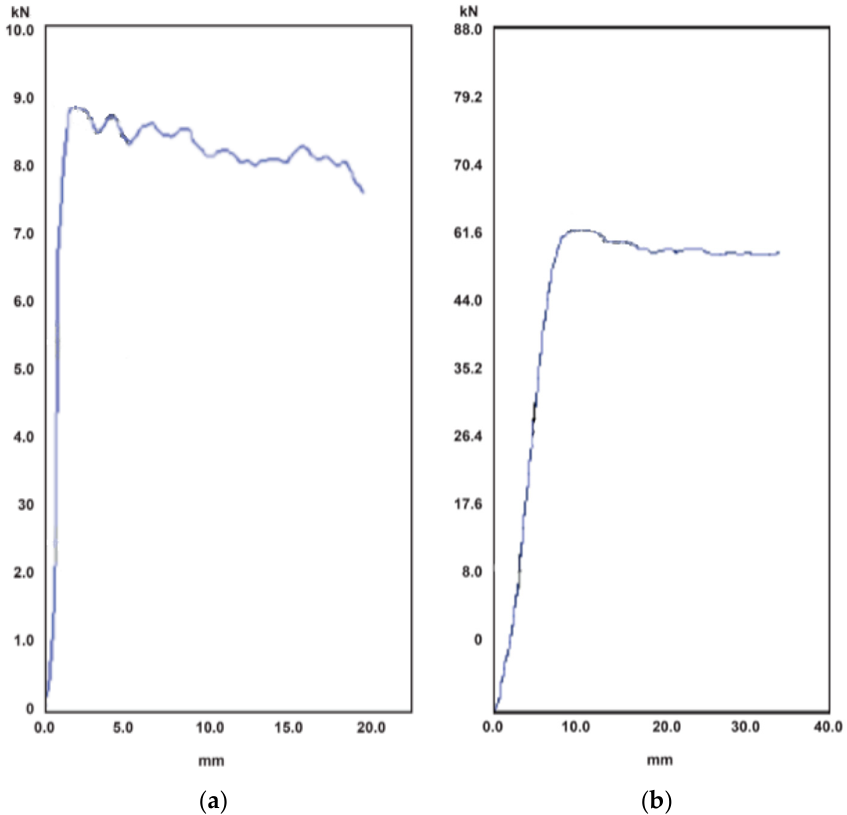
Figure 9. Force-displacement curves of the compression test of the following items: ( a ) B-01; ( b ) B-03.